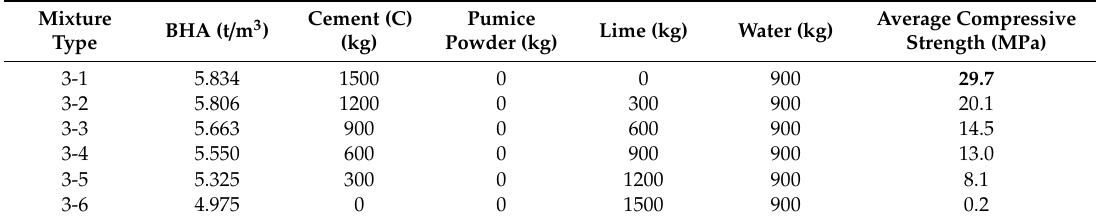
Table 24. Type-3 mixture quantity, unit volume weight and compressive strength test results.